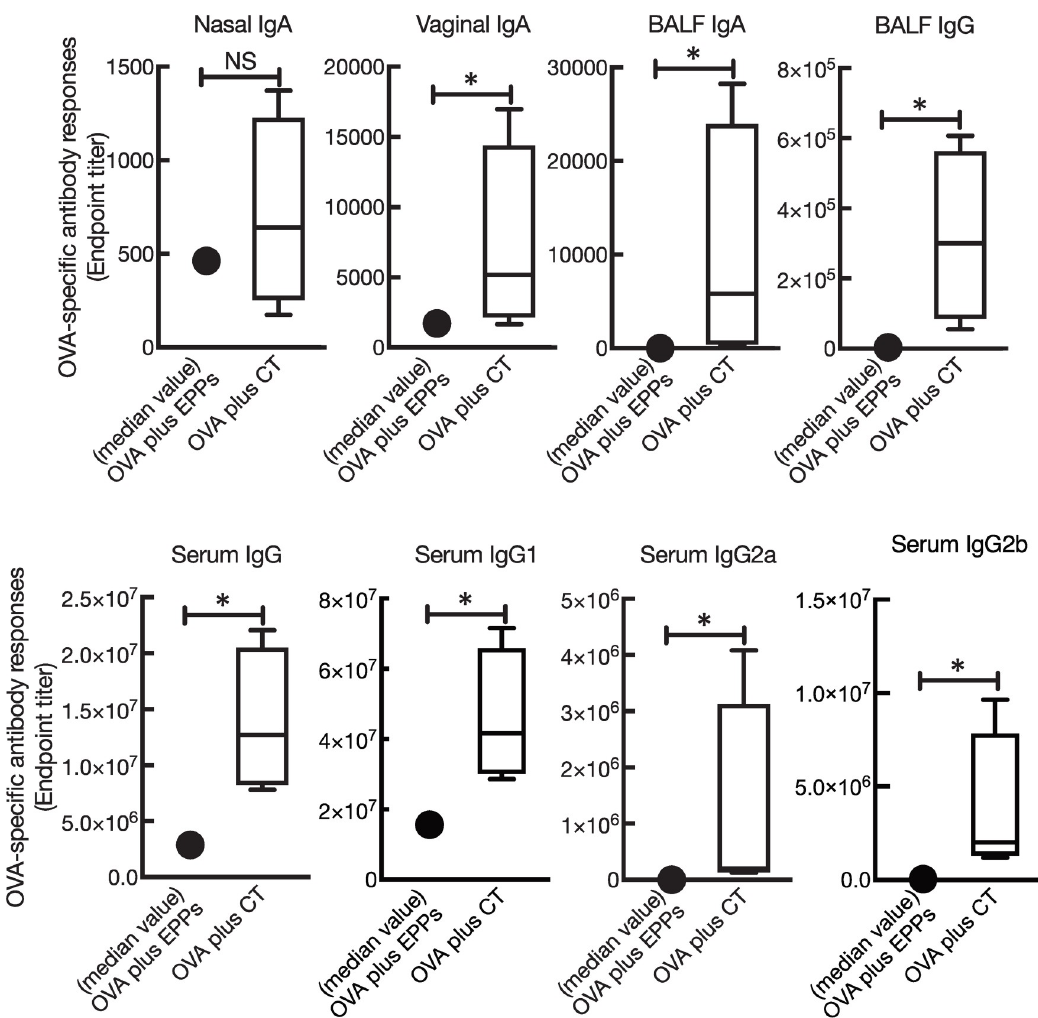
Fig 4. Comparison of the mucosal adjuvant effects of the enzymatically polymerised polyphenols with CT. Female BALB/ cCrSlc mice were immunised three times intranasally (days 0, 7, and 14) with OVA (2.5 μ g/mouse) plus either pCA (100 μ g/ mouse), pFA (100 μ g/mouse), or pCoA (100 μ g/mouse), or OVA (2.5 μ g/mouse) plus CT (1 μ g/mouse). ELISA detected OVA- specific IgA endpoint titres in nasal wash and BALF; IgG endpoint titres in BALF and vaginal wash; and total IgG, IgG1, and IgG2a endpoint titres in sera on day 21. The data were obtained from three biologically independent experiments. OVA plus enzymatically polymerised polyphenols (EPPs); the median value of the sum of OVA plus pCA, OVA plus pFA, and OVA plus pCoA, n = 27; OVA plus CT, n = 9. The box-plot shows the median value with the 25th–75th percentiles and the error bars indicate the 5th–95th percentiles. Significance was calculated using the Mann-Whitney U test: � p < 0.05.